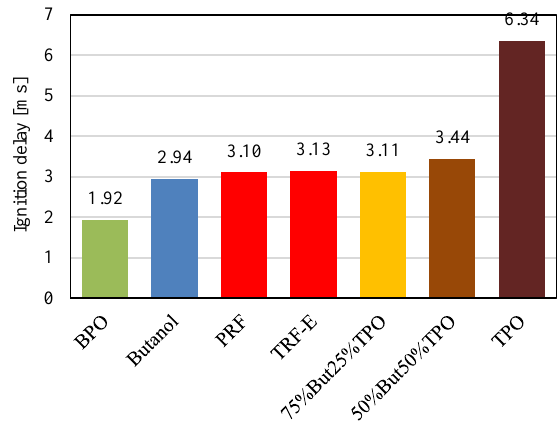
Fig. 22. Ignition delay of all research surrogates